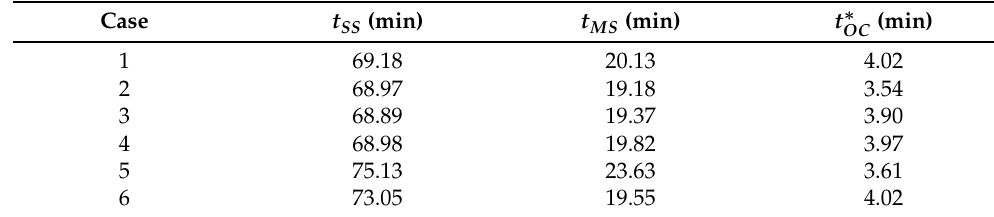
Table 5. Time needed to realize each simulation for NMPCs based on the different numerical methods. Case t SS